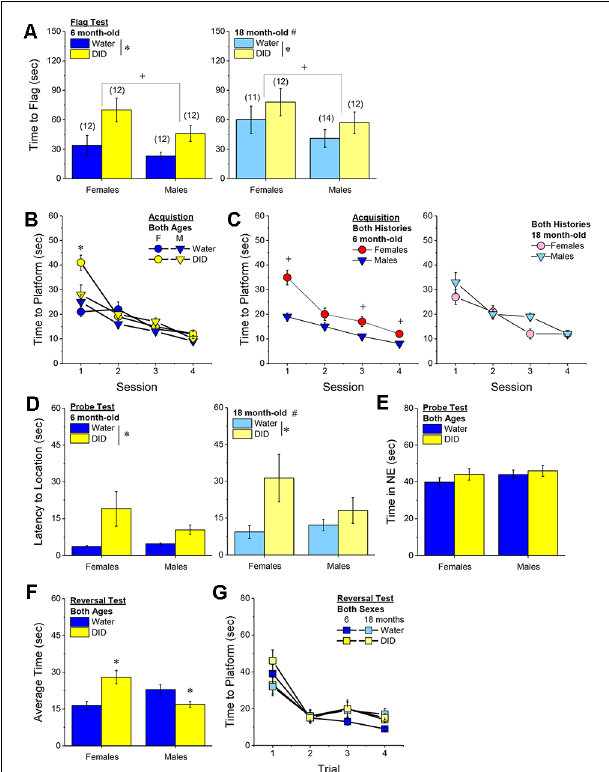
FIGURE 11 | Effects of binge drinking during later maturity (6 months of age) or old age (18 months of age) on Morris water maze performance in isogenic C57BL/6J mice. (A) Relative to water-drinking controls (Water), binge drinking (DID)mice in Experiment 3 exhibited a longer latency to locate a visible, flagged, platform, with 18-month-old mice and females requiring more time than 6 month-mice and males to locate the platform. (B) All mice readily acquired the location of a hidden platform in the Morris Maze over the 4-day course of training, although female DID mice required more time to locate the platform on Session 1. (C) Regardless of drinking history, female 6-month-old mice required more time than males to locate the hidden platform during maze acquisition (left) , with no sex difference detected in 18-month-old mice (right) . (D) On the probe test, DID mice exhibited a longer latency to first enter the former location of the hidden platform, irrespective of age or sex, although 18-month-old mice were more impaired, overall, than 6-month-old mice. (E) No binge drinking effects were detected for the amount of time spent in the NE quadrant that formerly contained the hidden platform, although males spent more time, overall, than females. (F) On the reversal test, female DID mice of both ages required more time, on average, to locate the relocated platform than their Water controls, while male DID mice spent less time than Water controls. (G) No overt group differences were detected for the time-course of reversal learning when the hidden platform was relocated within the maze. The data represent the means ± SEMs of the number of mice indicated in parentheses in Panel (A) . ∗ p < 0.05, DID vs. Water; + p < 0.05, Females vs. Males; # p < 0.05, 6 vs.